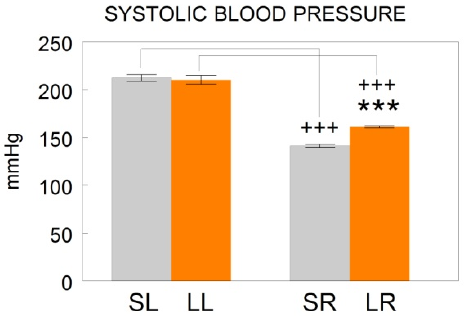
Figure 2. Mean ± SEM levels of systolic blood pressure values expressed in mmHg after saline injection into the left (sham left; SL; n = 10) or right (sham right; SR; n = 10) striatum or after 6-hydroxydopamine injection into the left (lesioned left; LL; n = 10) or right (lesioned right; LR; n = 10) striatum of spontaneously hypertensive adult male rats. *** indicates a significant difference of p < 0.001 between sham versus lesioned animals in the same side. +++ indicates a significant difference of p < 0.001 between sham left versus sham right or between lesioned left versus lesioned right animals. Modified from [46].